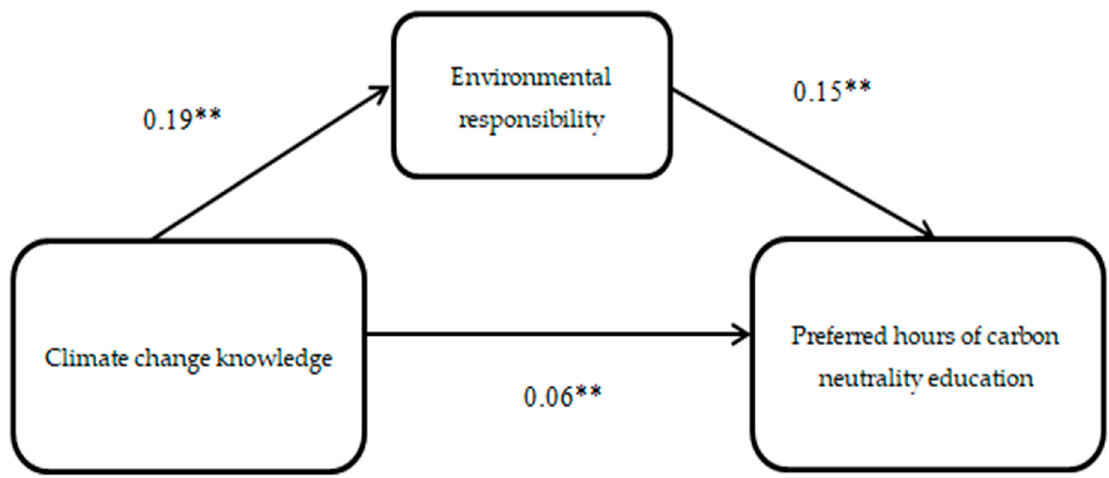
Figure 4. Model of preferred hours of carbon neutrality education. Note: ** p < 0.01.